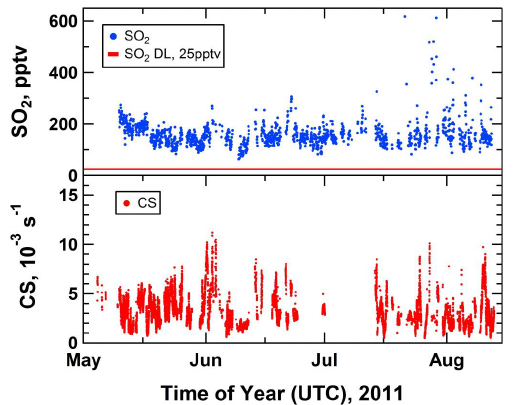
Figure 4. Top: SO 2 mixing ratios (1h signal integration) mea- Figure 4. 1031 sured in marine air between May and August 2011 (average: 160 ( ± 50)pptv; detection limit: 25pptv, indicated by red line). Bottom: condensational sink (CS; 5min integration) calculated for H 2 SO 4 (see text).